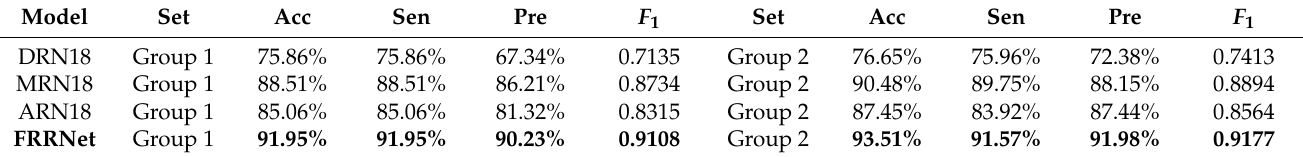
Table 8. Identification accuracy